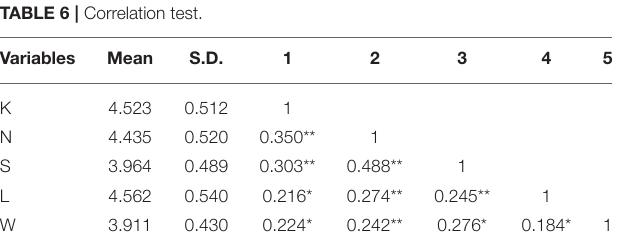
TABLE 6 | Correlation